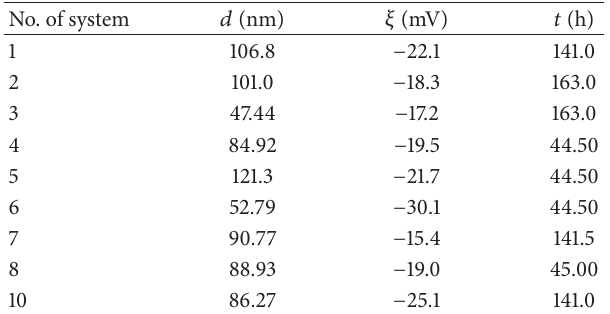
Table 5: Results of the average particle size and stability of nanosilver suspension.